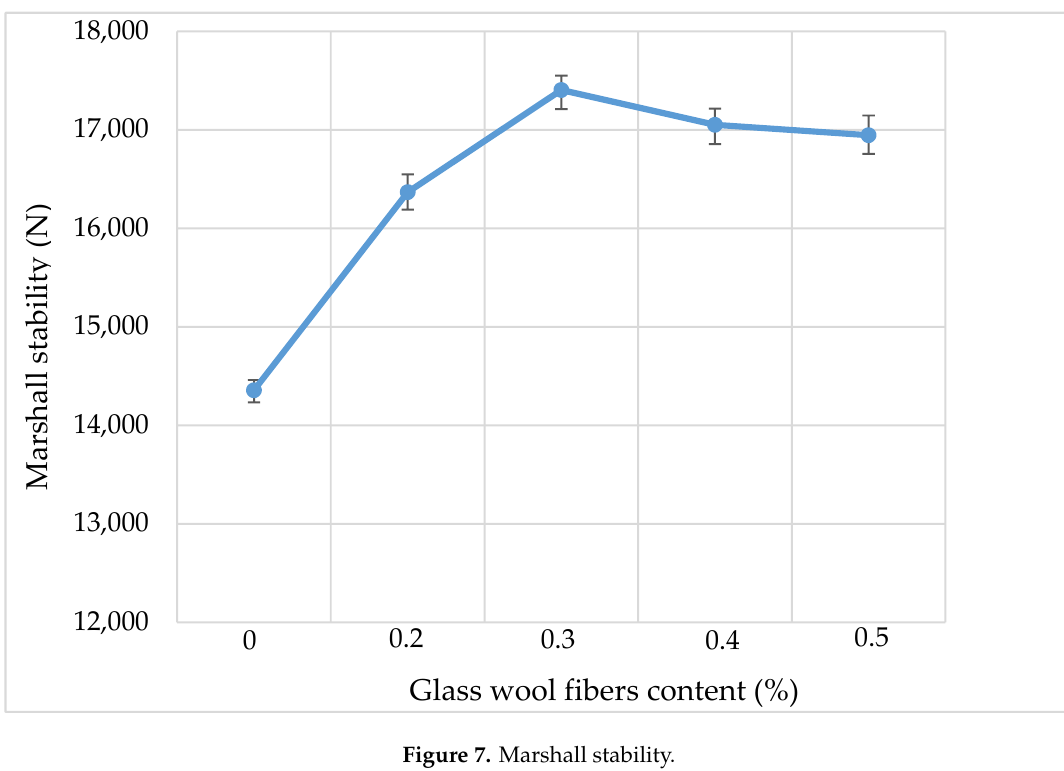
Figure 7. Marshall stability.